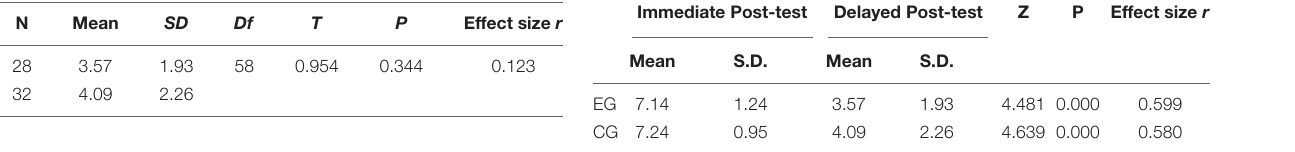
TABLE 6 | Wilcoxon signed rank test comparison between the immediate and delayed